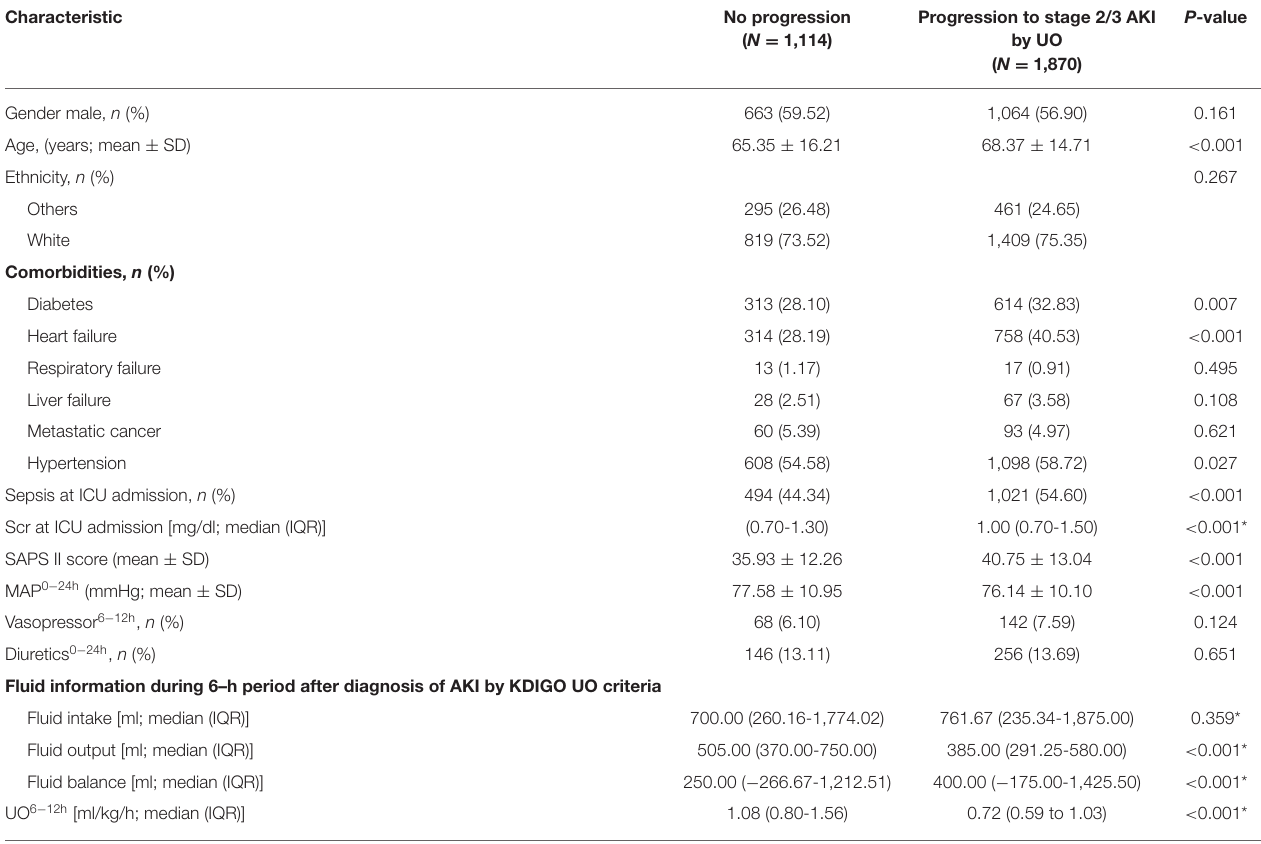
TABLE 1 | Baseline characteristics of participants ( N = 2,984).